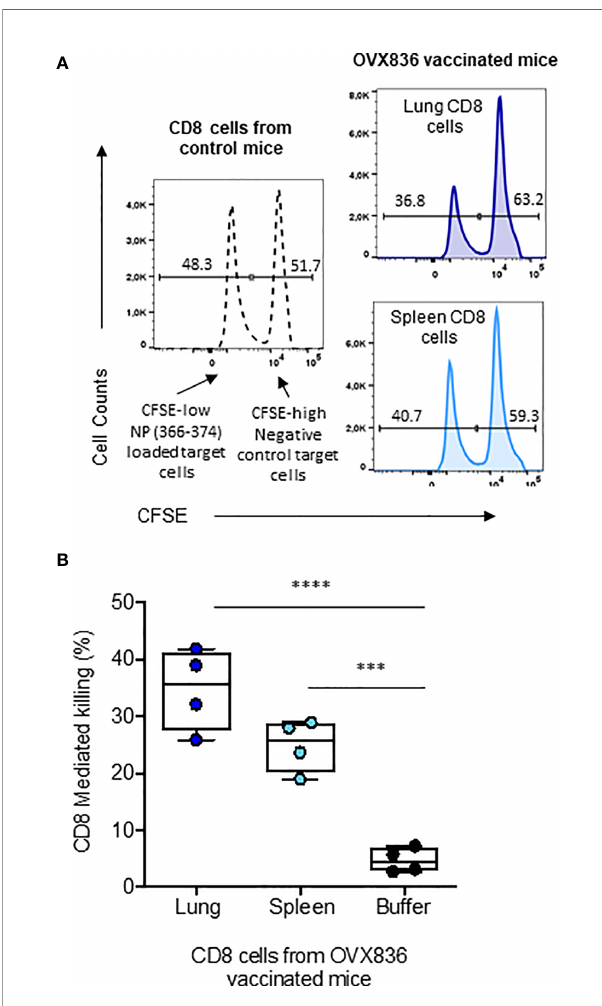
FIGURE 6 | NP-speci fi c CD8+ T-cells from OVX836-immunized mice are cytotoxic effector cells. (A) Splenocytes from naive C57/B6 mice were labelled with CFSE: the CFSE low peak corresponds to NP 366 – 377 -pulsed target cells, the CFSE high peak corresponds to unpulsed target cells. CFSE target cells were mixed at a 1:1 ratio and incubated for 16 h with sorted CD8+ T-cells isolated from the lungs and spleens of OVX836-vaccinated mice to measure antigen-speci fi c CD8+ T-cell-mediated killing. (B) The data are representative of two separate experiments yielding similar results, represented in box-and-whisker plots (min and max, all points are shown) in the right panel. Differences were assessed by one-way ANOVA followed by Tukey ’ s multiple comparison test. Signi fi cance was set at ***p < 0.001, ****p <